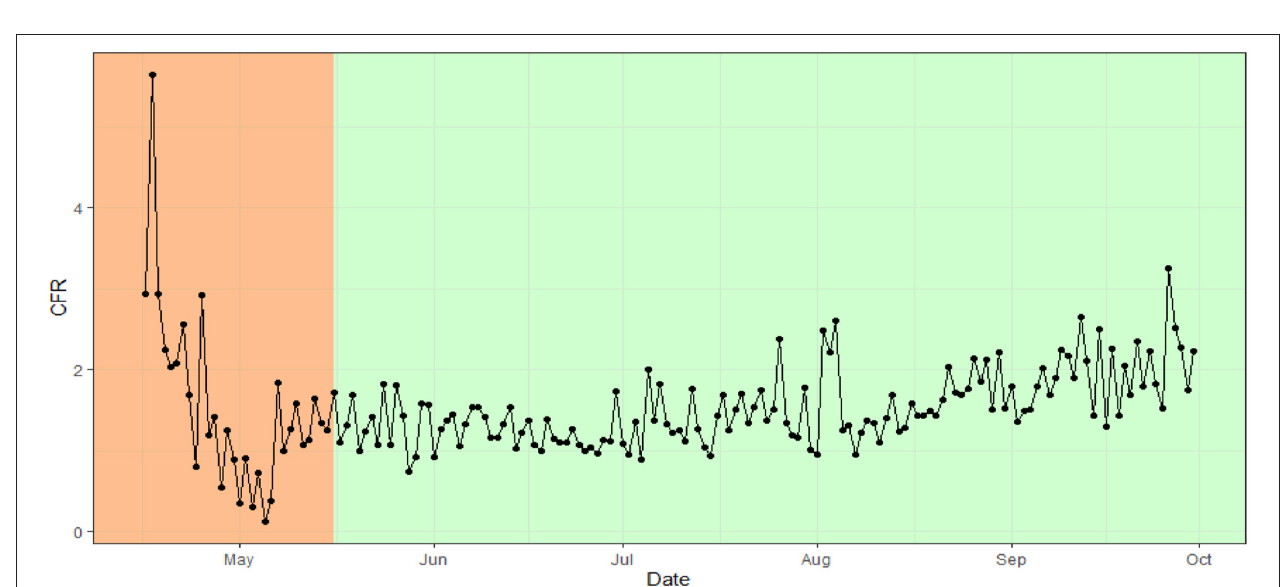
FIGURE 6 | Cases per test (100) rate in Bangladesh over time.